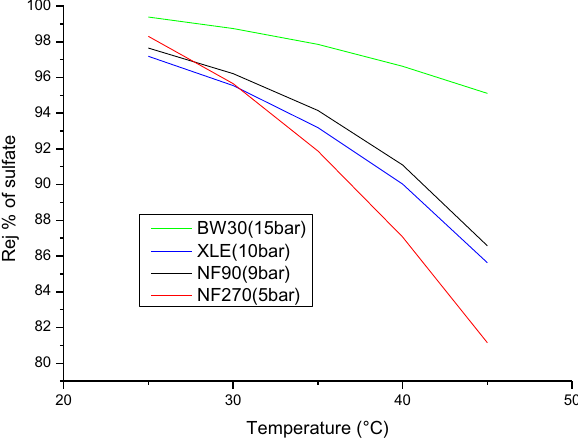
Fig. 11 Effect of temperature on TH % removal at optimum feed pressure for conf b